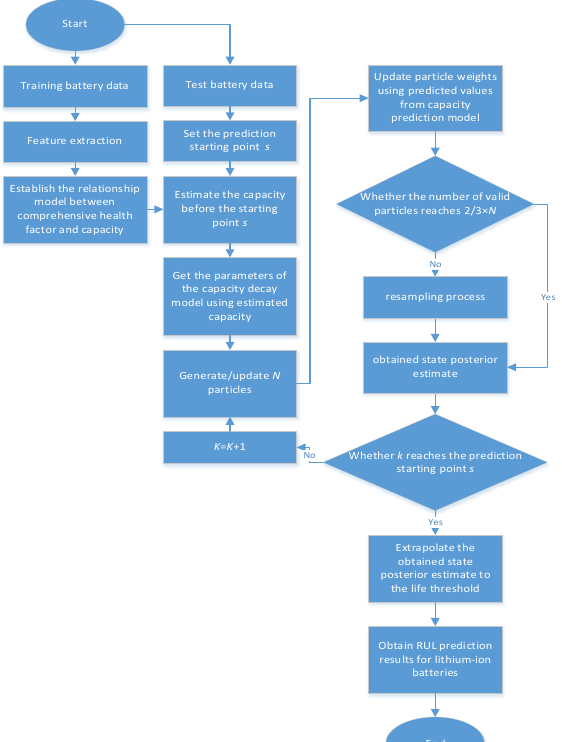
Figure 7. Flow chart of the proposed RUL prediction